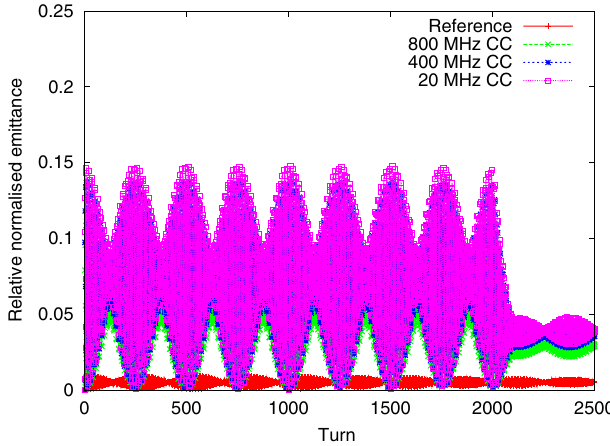
FIG. 20. (Color) Relative horizontal emittance growth due to the crab cavity ramping with different frequency crab cavities (20, 400, and 800 MHz), longitudinal cut at 1 (cid:3) , with 1 turn ramping speed. The transverse emittance growth is due to particles in the longitudinal tails.